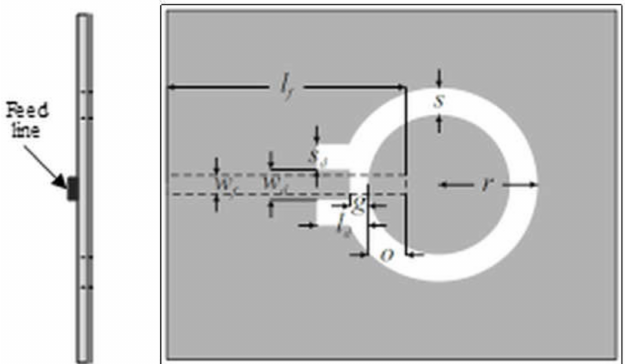
Figure 7. Geometry of the ring slot antenna with a microstrip feed (dashed line) [67].